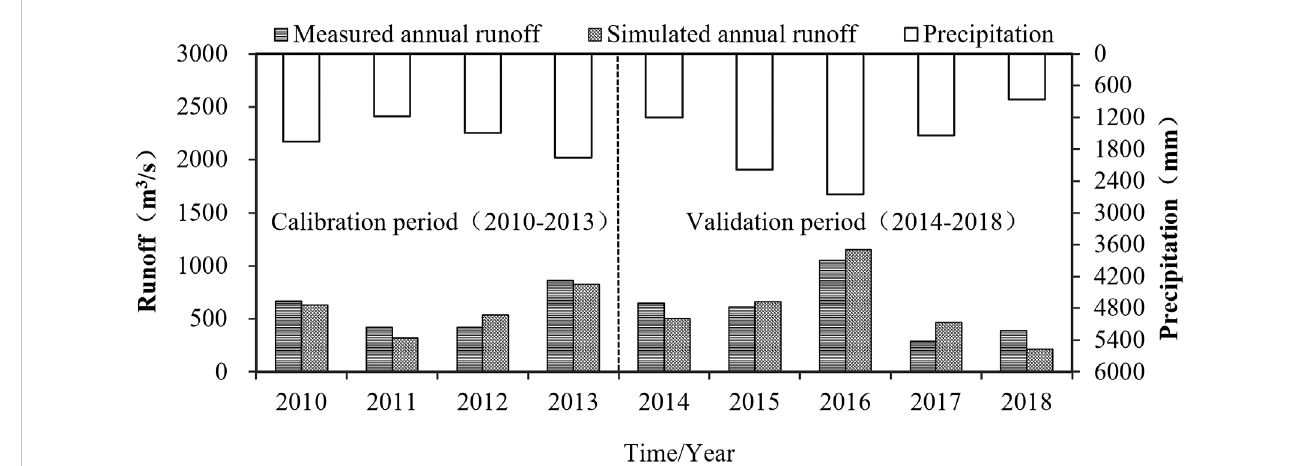
FIGURE 2 Comparison of observed and simulated runoff at annual scale during calibration and validation periods.